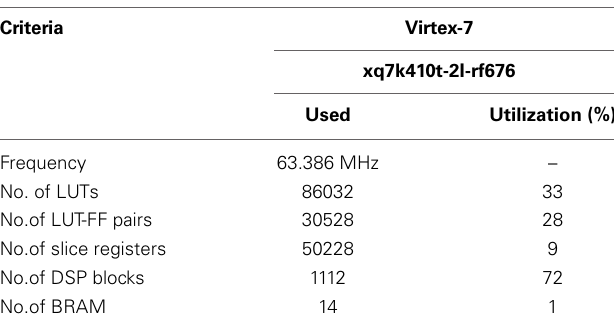
Table 1 | Abstract of synthesis results.